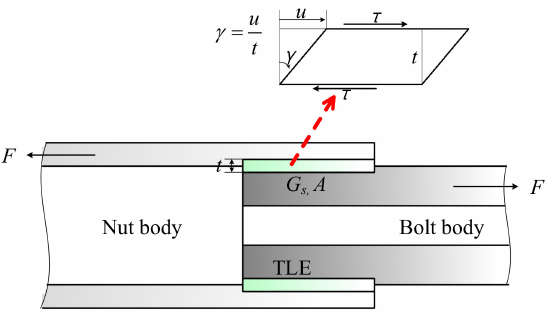
Figure 6. Axial deflection of the TLE (source elaborated by authors based on